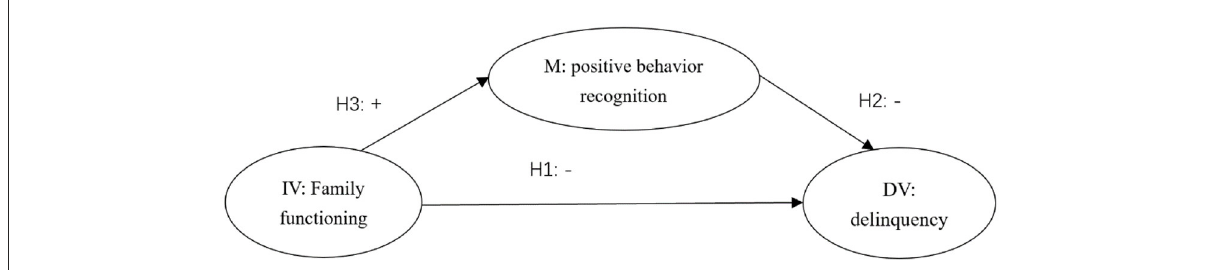
FIGURE1 Hypothesized association among family functioning attributes, positive behavior recognition, and adolescent delinquency. IV, independent variable; M, mediator; DV, dependent